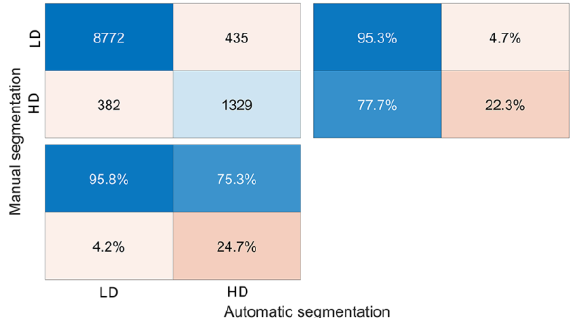
Figure 17. Confusion chart for manual/automatic segmentation;